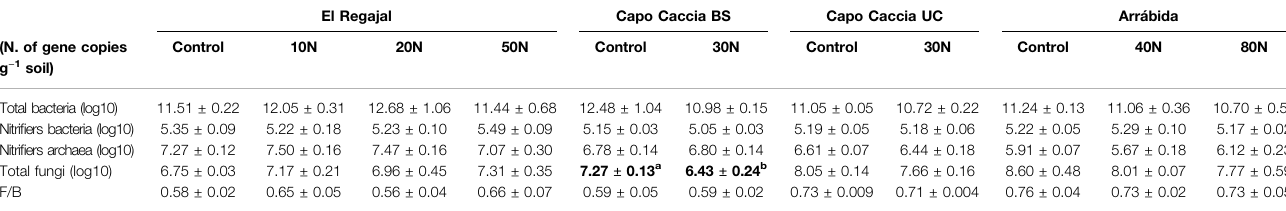
TABLE4| Soilmicrobialcommunity(means ± SE)inthetop8 cmofthesoilpro fi leforeachNtreatmentinElRegajal(Spain, n (cid:2) 6),CapoCacciaBS(Italy, n (cid:2) 4),CapoCaccia UC (Italy, n (cid:2) 4) and Arrábida (Portugal, n (cid:2) 3). Capo CacciaBSand Capo Caccia UC indicate bare soil and under canopy microsites, respectively. Statistical differences (one-way ANOVA, post hoc LSD test) are highlighted in bold and letters indicate signi fi cant differences ( p < 0.05) among N treatments within each site.